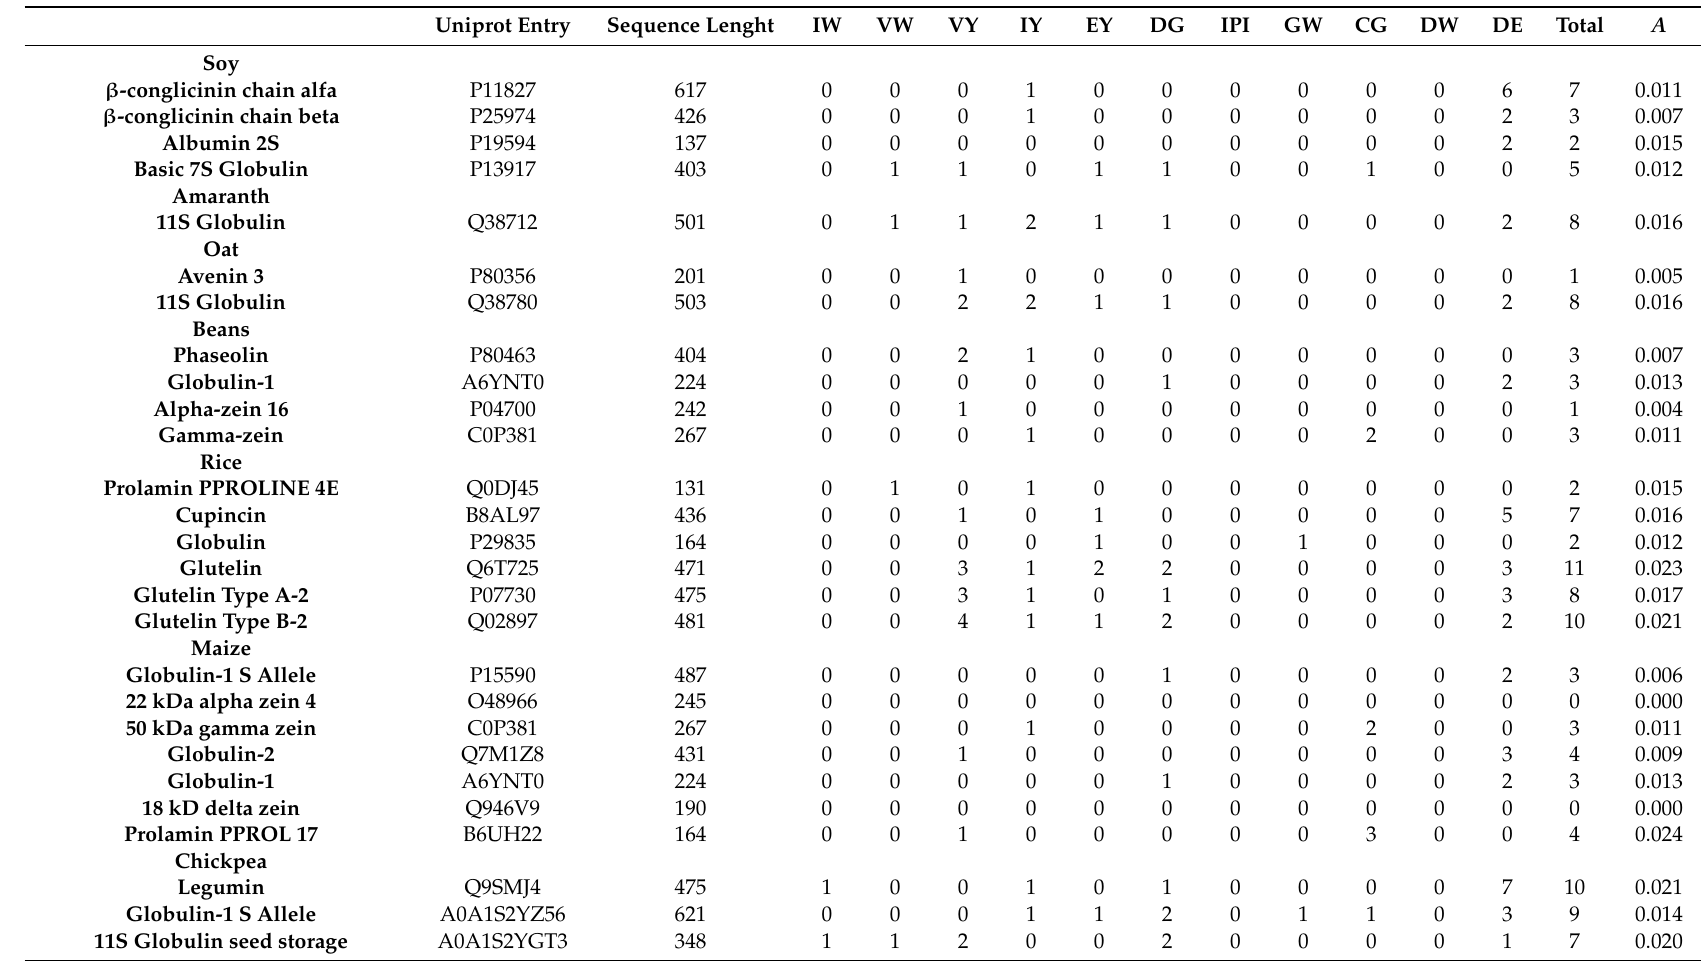
Table 2. Frequency of the selected bioactive peptides in vegetable proteins and their A number (relative frequency of bioactive peptides able to treat metabolic